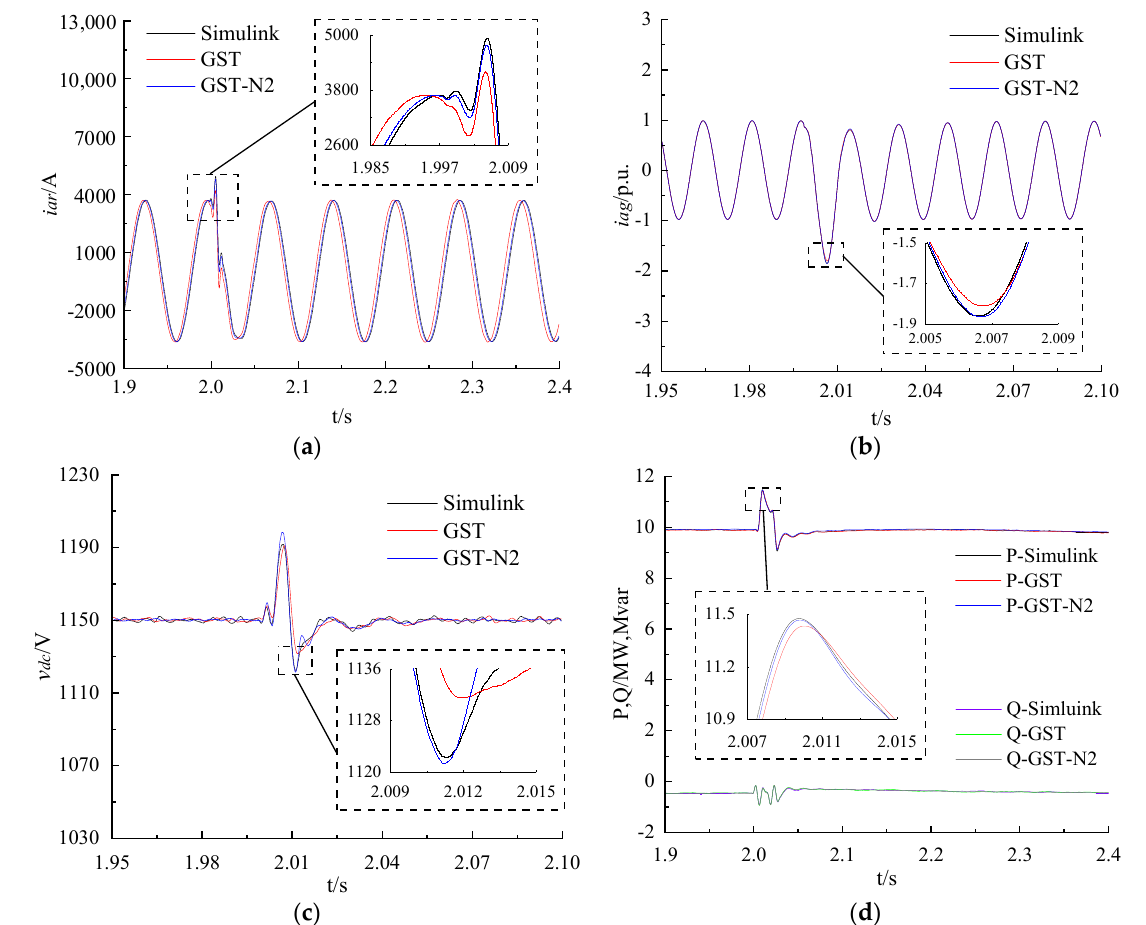
Figure 17. Comparison of simulation waveforms in scenario B: ( a ) Rotor-side current waveform; ( b ) Connection point current waveform; ( c ) DC capacitance-voltage waveform; ( d ) P,Q waveform.